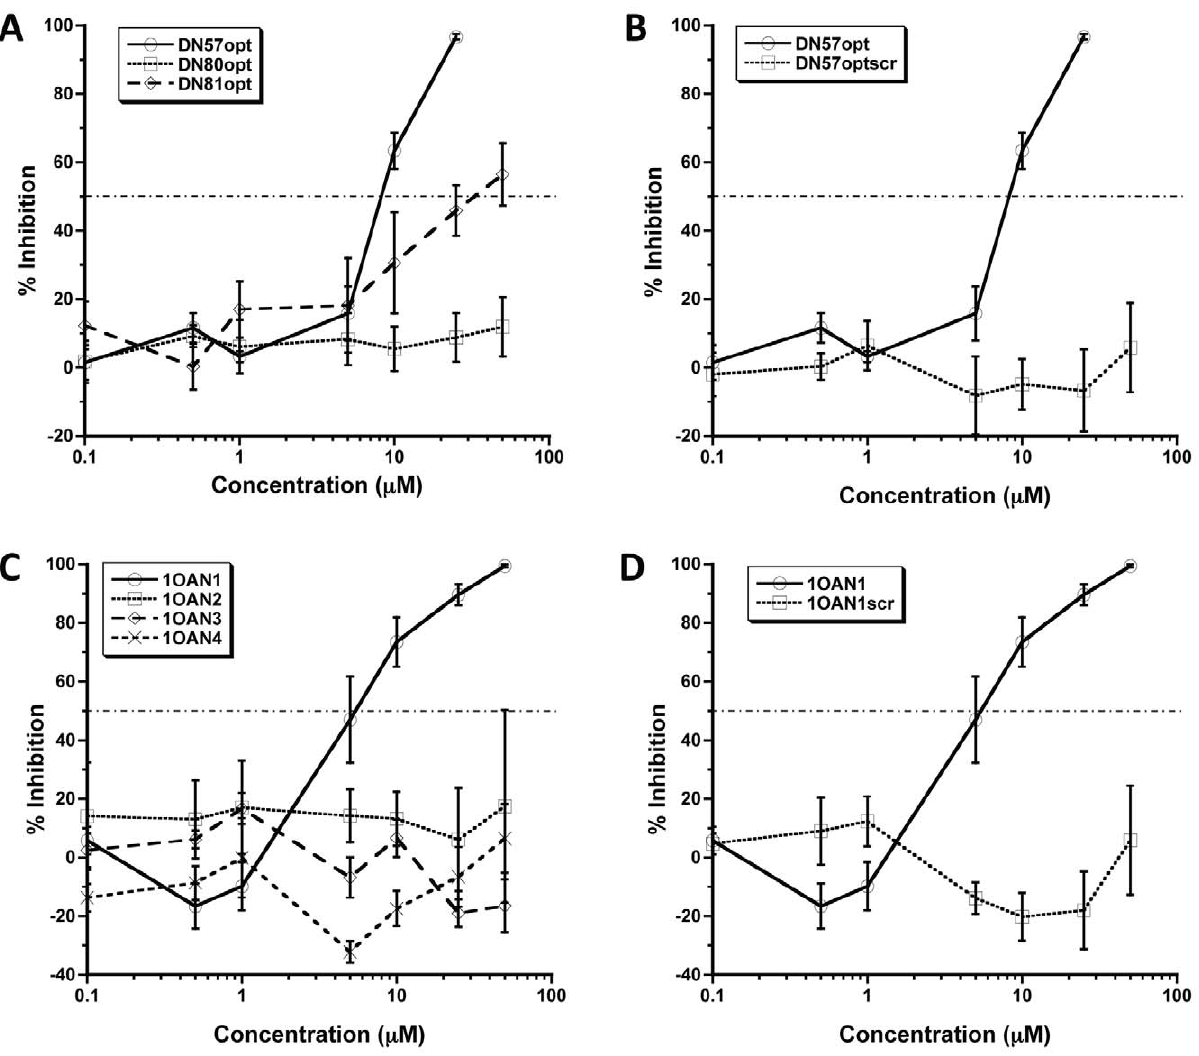
Figure 2. Inhibition of DENV-2 invitro . Increasing concentrations of optimized inhibitor peptides and corresponding scrambled peptides of identical composition were tested against DENV-2 in a focus forming unit reduction assay. (A) Optimized peptides (B) DN57opt and corresponding scrambled peptide of identical composition (C) Novel peptides (D) 1OAN1 and corresponding scrambled peptide of identical composition. Error bars are 6 sem.